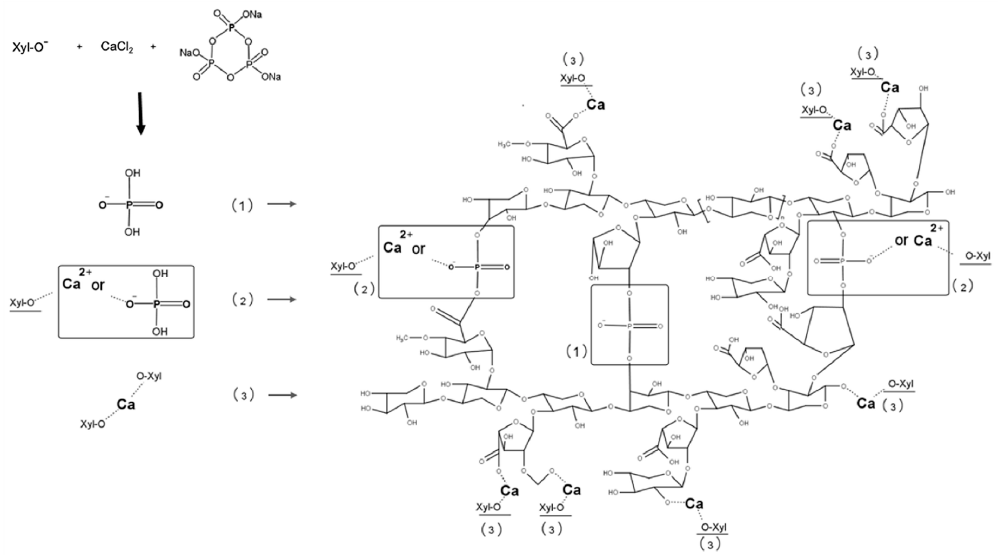
Figure 4. Scheme of the crosslinking reaction between xylan (Xyl), CaCl 2 , and STMP. Reaction (1) represents only the chemical bond between STMP-Xyl. Reaction (2) represents the process of chemical crosslinking between Ca 2 + -Xyl-STMP, respectively, and Reaction (3) represents the ionic interaction between Ca 2 + -Xyl.